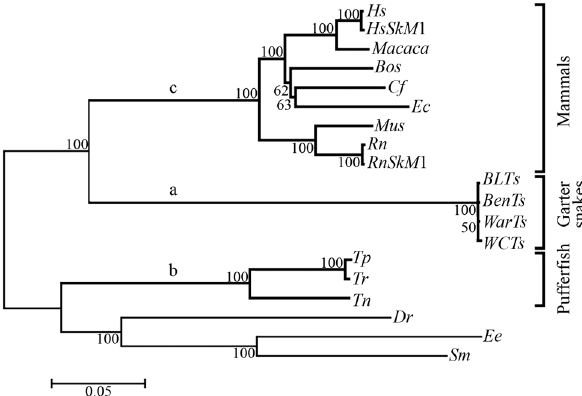
Figure 1 - Phylogenetic tree of Na v 1.4 channel genes in vertebrates. The phylogenetic tree was constructed with MEGA 4.0 using the Neigh- bor-Joining method. The reliability of the tree was evaluated by the boot- strap approach with 1000